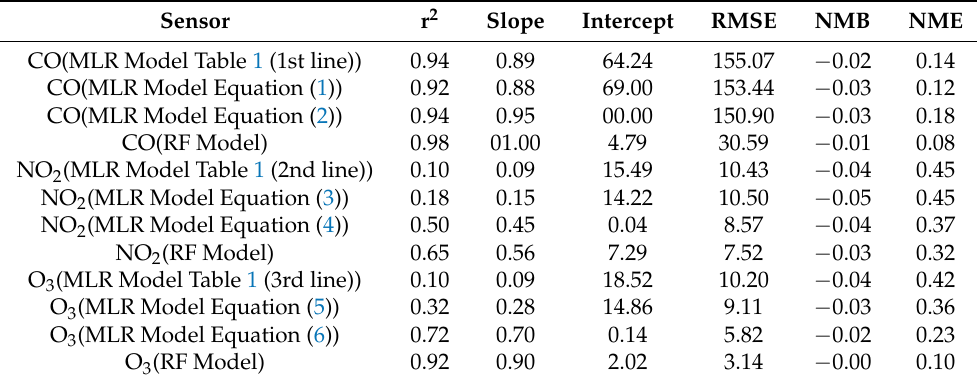
Table 6. Evaluated model prediction